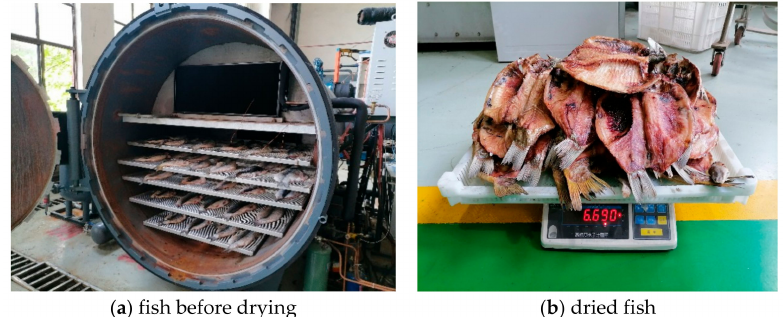
Figure 4. The fish in the drying